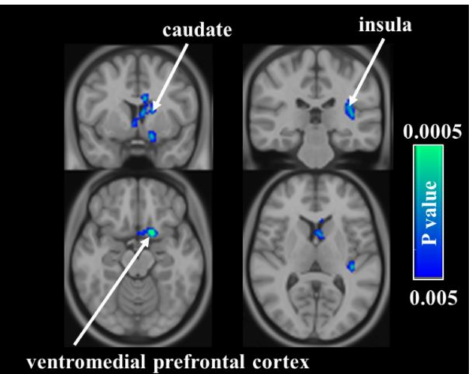
Figure 3. Comparison of cerebral blood flow (CBF) between two time-points in the sham group. Voxelwise analyses demonstrate decreases in CBF in the left ventromedial prefrontal cortex, left caudate, and left insula.